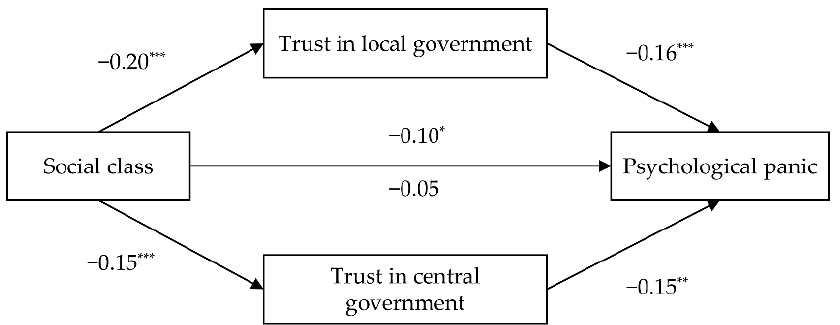
Figure 2. Mediating role of trust in government on the relationship between SES and psychological panic, controlling for risk degree, age, and gender (* p < 0.05, ** p < 0.01, *** p < 0.001).